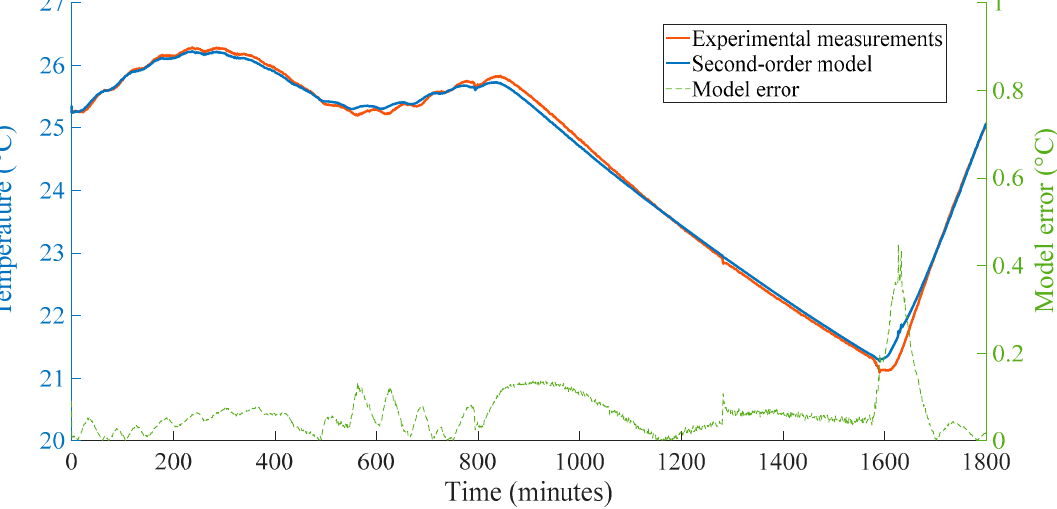
Figure 5. Second-order model versus experimental measurements and model error.